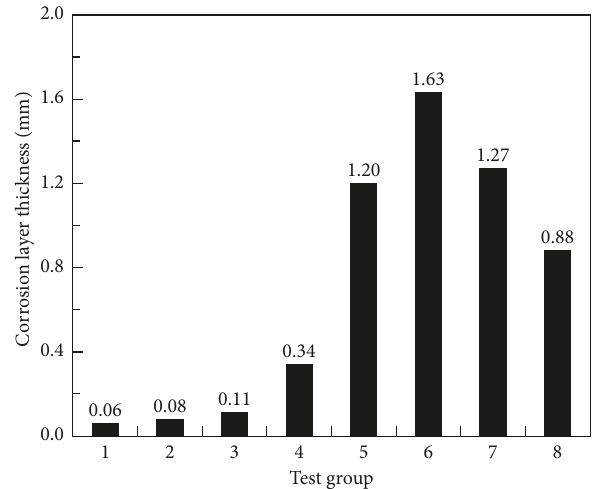
Figure 4: Corrosion layer thickness of concrete subjected to sulfuric acid corrosion after 150